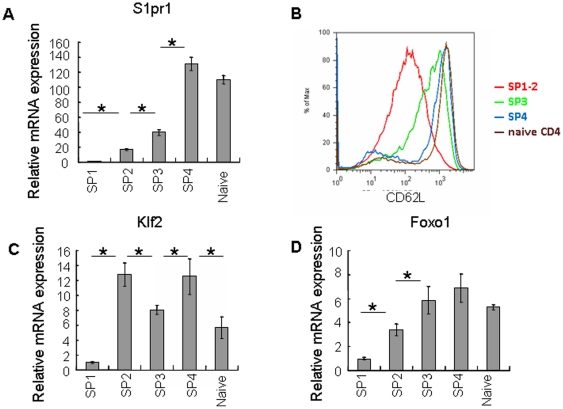
Expression of genes that are involved in the thymocyte migration and in Foxo1-Klf2 axis.(A, C–D) Relative mRNA amount of S1pr1, Klf2, and Foxo1 in naïve CD4+ T cells and the four subsets of CD4 SP thymocytes as determined by real time RT-PCR. (B) Expression of CD62L as determined by flow cytometry in peripheral naïve CD4+ T cells, double positive thymocytes, and the four subsets of CD4 single positive thymocytes. Asterisks indicate significant (p<0.05) change compared between the two subsets. The experiment was repeated for two to three times and similar results were seen.